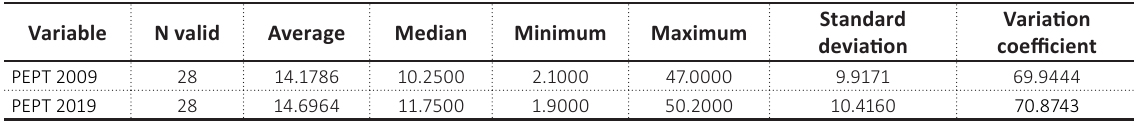
Source: Eurostat (2021a).